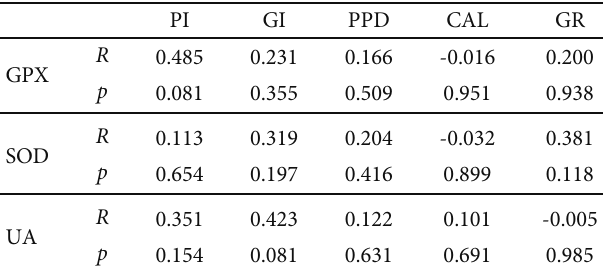
Table 3: Correlation among antioxidants and periodontal clinical parameters in the SSc group.